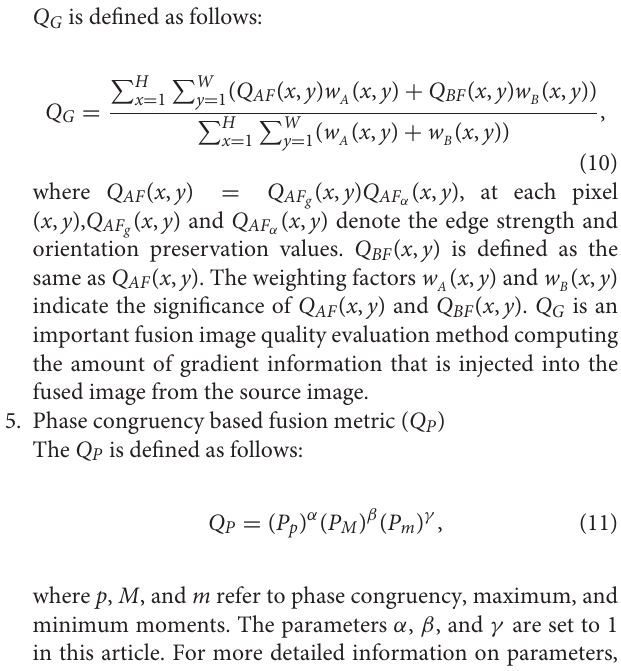
Frontiers in Neurorobotics |